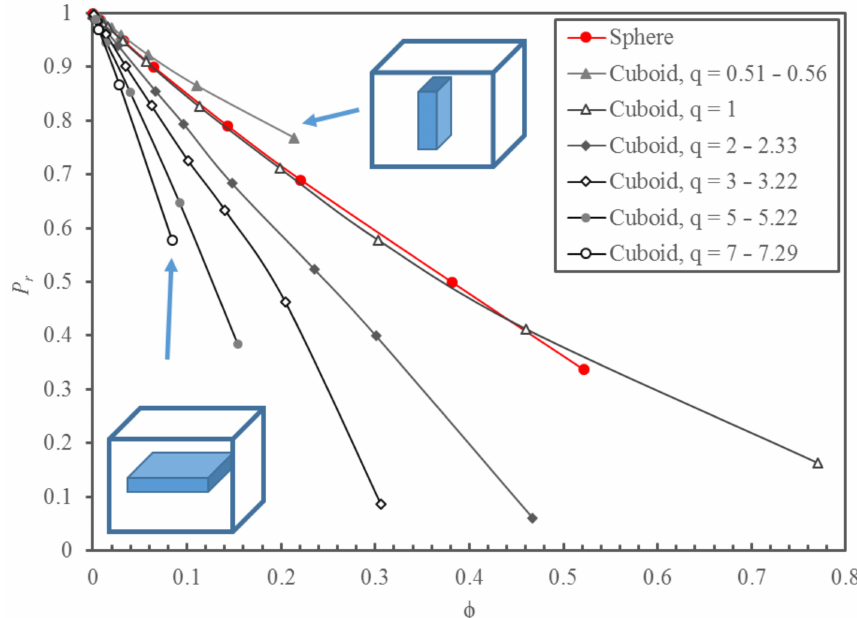
Figure 3. Plots of the relative permeability P r of MMMs as a function of the solid volume fraction φ for spherical and cuboid impermeable nanoparticles, grouped by narrow ranges of the aspect ratio q . Data points were obtained numerically, and the solid lines are trend lines. The permeability of the continuous phase was kept constant at 5 × 10 − 12 m 2 / s (5.0 × 10 − 11 m 2 / s di ff usivity and 0.10